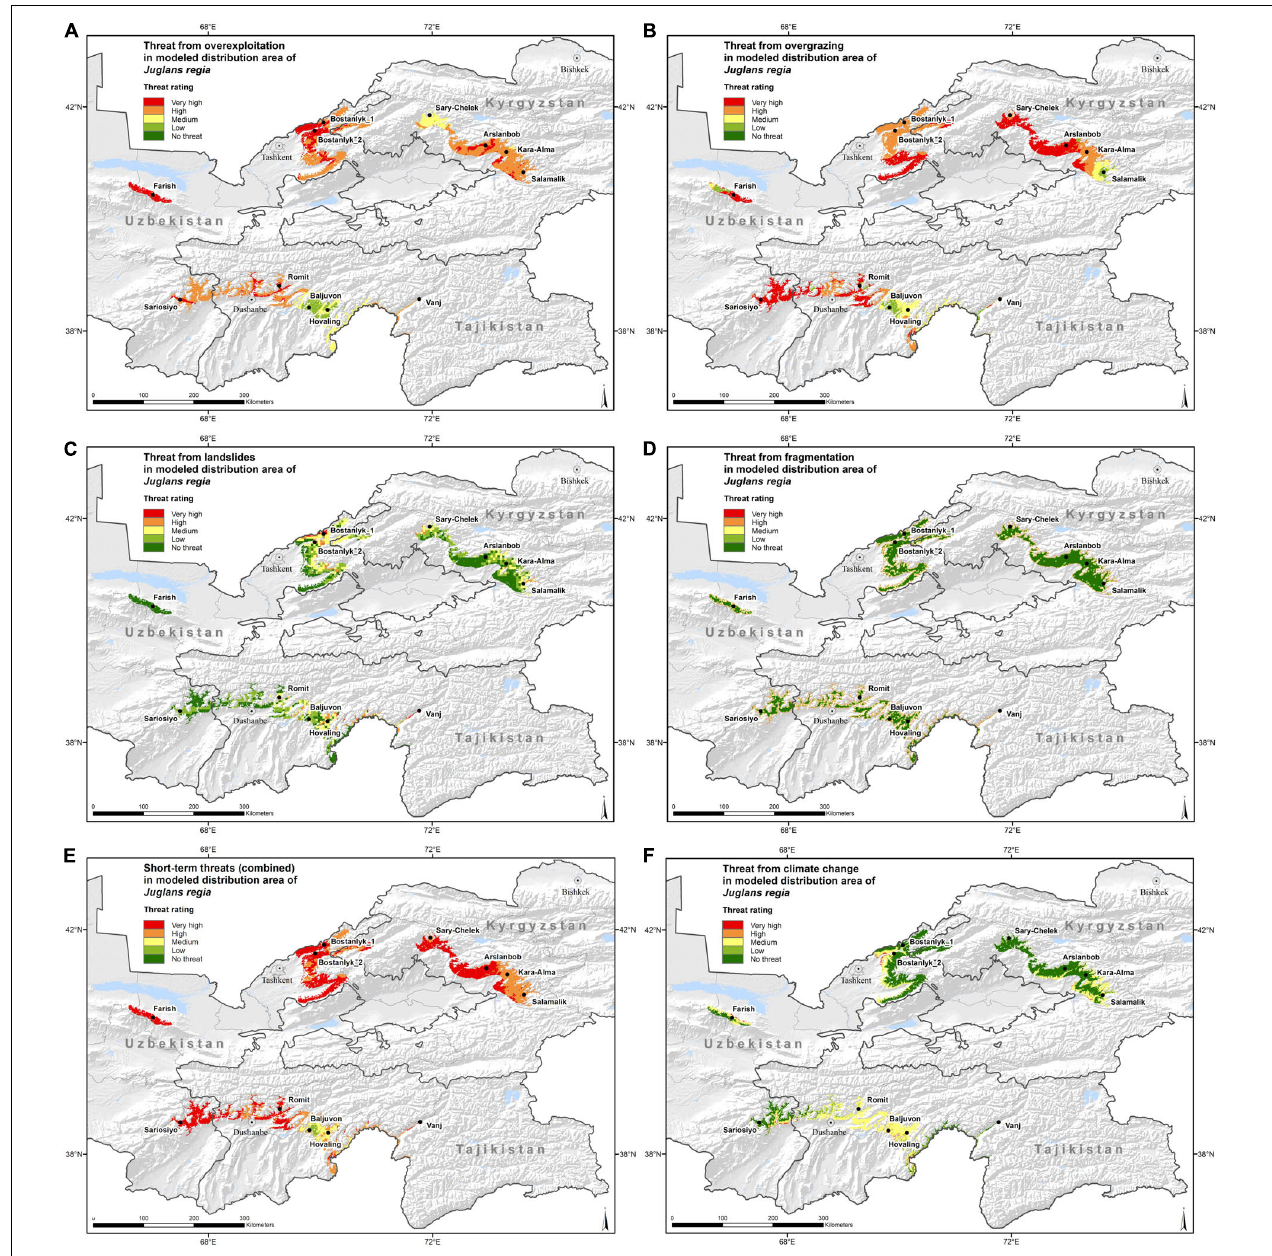
FIGURE 5 | Maps with threat magnitude levels of (A) “Overexploitation,” (B) “Overgrazing,” (C) “Landslides,” (D) “Fragmentation,” (E) “Short-term threats (combined),” and (F) “Climate change” for the distribution range of wild walnut populations in Kyrgyzstan, Tajikistan and Uzbekistan. The criteria to define the threat levels are presented in Table 4